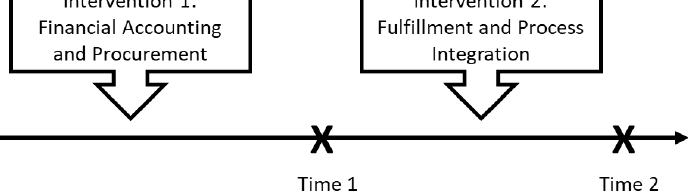
Figure 1. Longitudinal